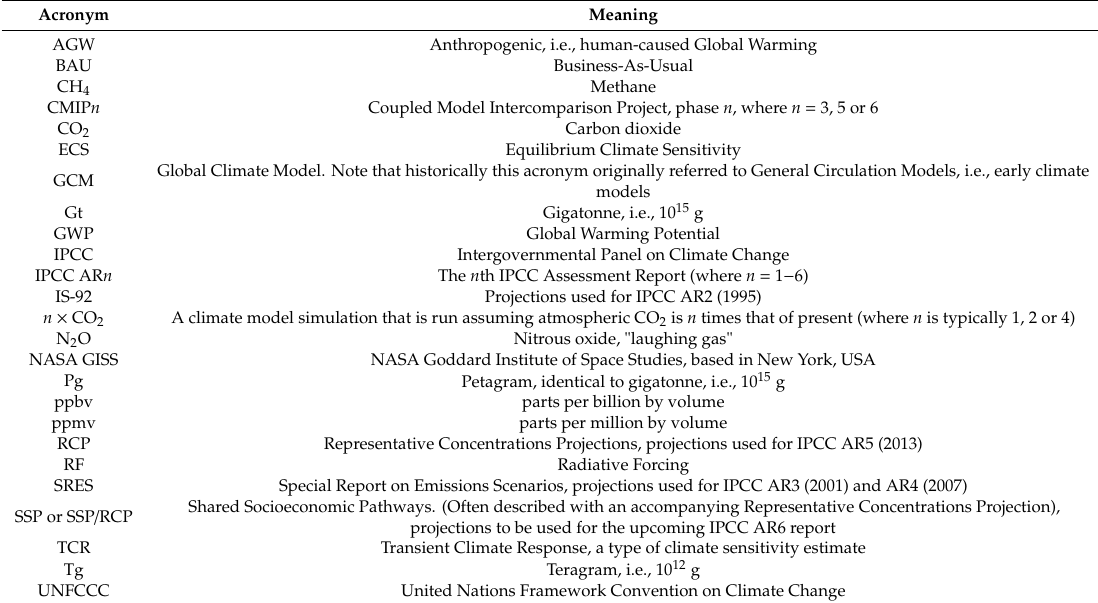
Table 3. List of acronyms, abbreviations, and shorthands used in this